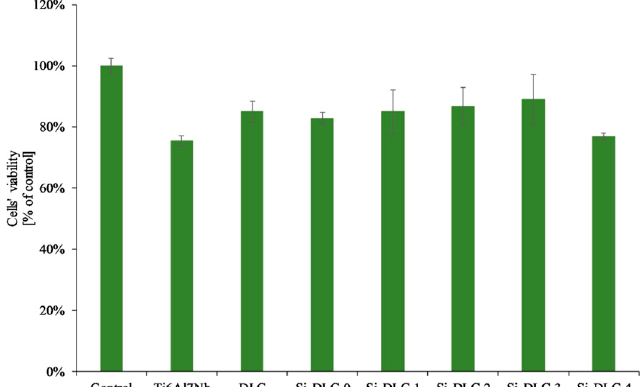
Figure 9. Endothelial cells’ viability in direct and indirect contact with the deposited Si-DLC coatings (XTT assay).